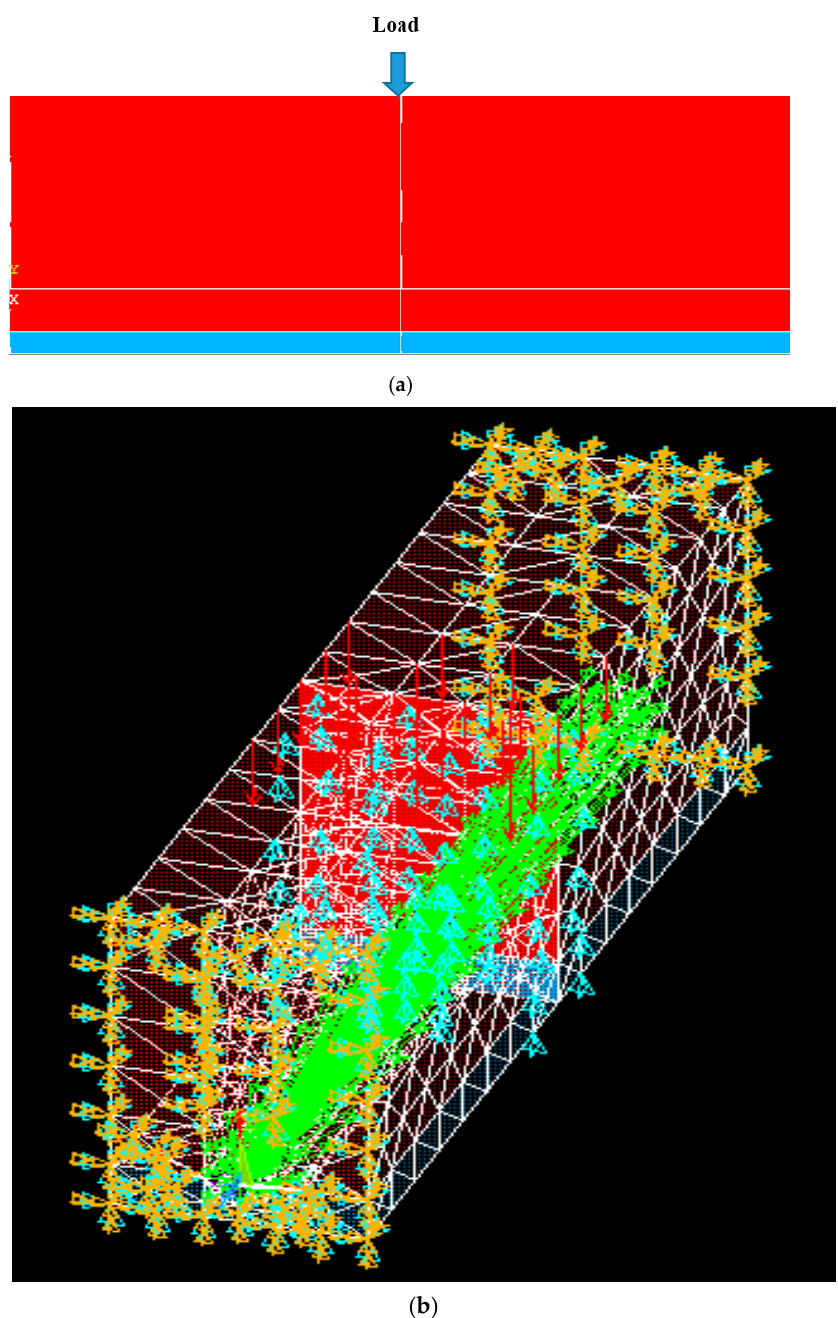
Figure 16. The settlement of applied static loadings in ( a ) 2D and ( b ) 3D view. Table 11. Compressive strength of various mixes without alkaline solution (AS).